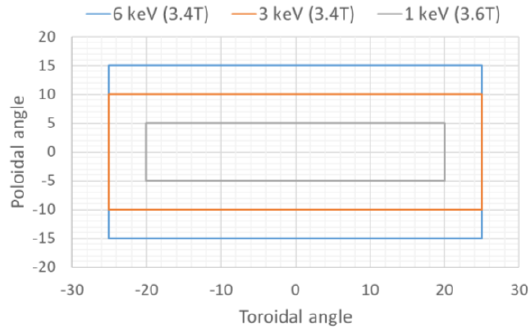
Figure 7: Restricted domain for the middle mirror, depending on electron temperature and central magnetic field.